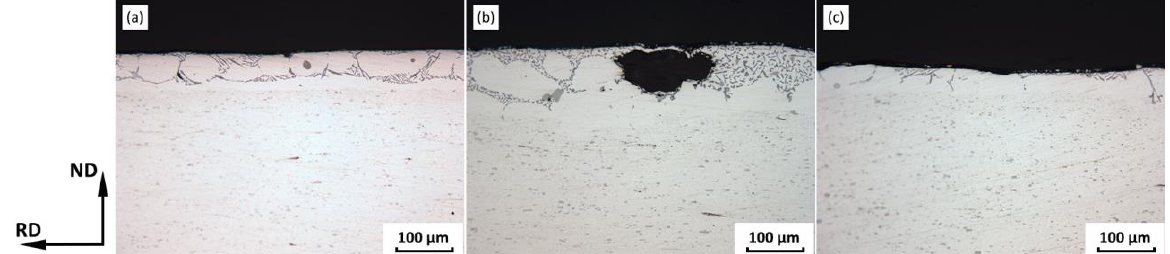
Figure 5. Optical microstructure of cross section of the brazing sheets after brazing, ( a ) Sample A, ( b ) Sample B, ( c ) Sample C.